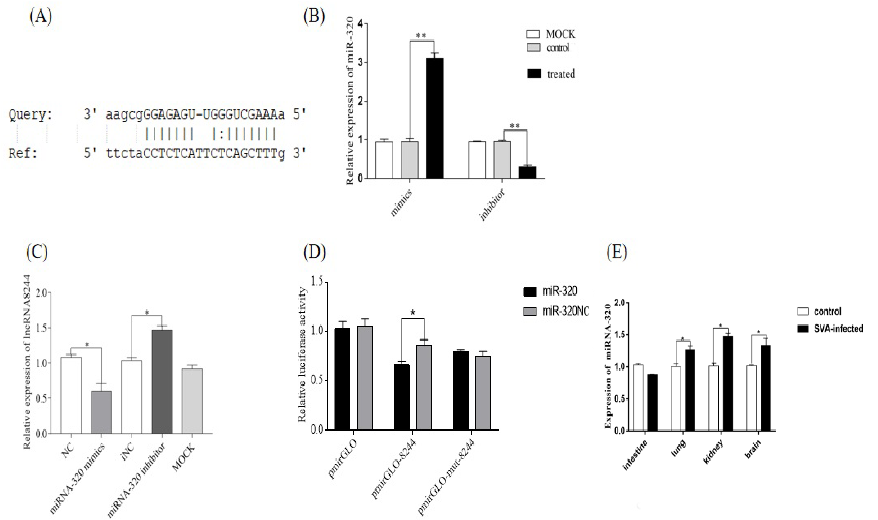
Figure 4. MiR-320 is the target gene of lncRNA 8244. ( A ) Predicted binding sites for miR-320 on the lncRNA 8244 transcript. ( B ) The expression level of miR-320 ( C ) The expression level of lncRNA 8244 after infected with SVA (MOI = 1.5) ( D ) Luciferase activity in PK-15 cells co-transfected with luciferase reporter containing pmirGLO-8244 or pmirGLO-mut-8244 and the mimics of miR-320. Data are presented as the relative ratio of Renilla luciferase activity and firefly luciferase activity. ( E ) The expression level of miR-320 in clinical samples of SVA-infected piglets. The mRNA level of TLR3 was normalized to the mRNA level of GAPDH, and anti- β -actin was used as a control for Western blot sample loading. All data are represented as mean ± SD with three replicates. * p < 0.05; ** p < 0.01.